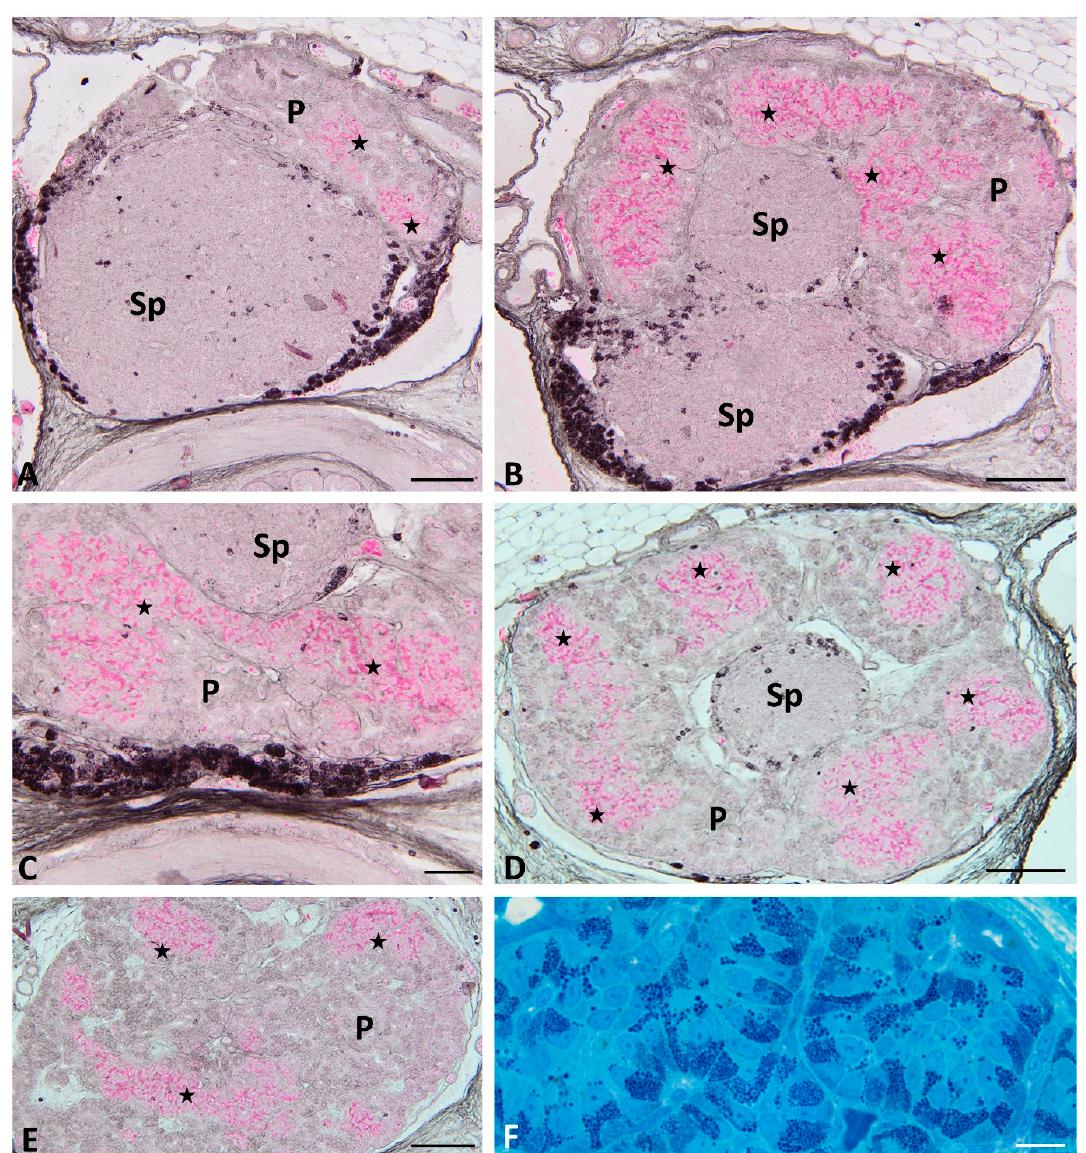
Figure 3. Transverse sections through the pancreas of the grass snake embryos at developmental stages IX–XI stained with phloxine and gallocyanin ( A , B , D , E ) and methylene blue ( F ). ( A ) Section through the most cephalic part of the pancreas. Scale bar = 100 µ m. ( B ) Note splenic “bulb”. Scale bar = 100 µ m. ( C ) Note connecting pancreatic islets. Scale bar = 20 µ m. ( D ) Pancreatic islets forming ring around the splenic “bulb”. Scale bar = 100 µ m ( E ) Small pancreatic islets within more caudal part of the dorsal pancreas. Scale bar = 100 μ m. ( F ) Pancreatic islets forming large cords. Scale bar = 10 μ m Abbreviations: P: pancreas; Sp: spleen; asterisk—pancreatic islets.